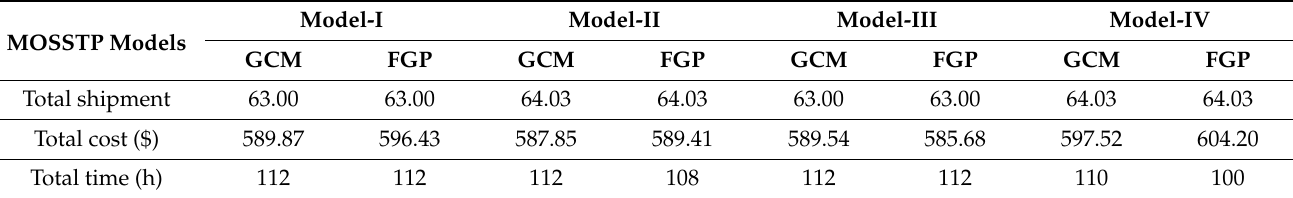
Table 6. Comparison between the two results obtained using GCM and FGP.